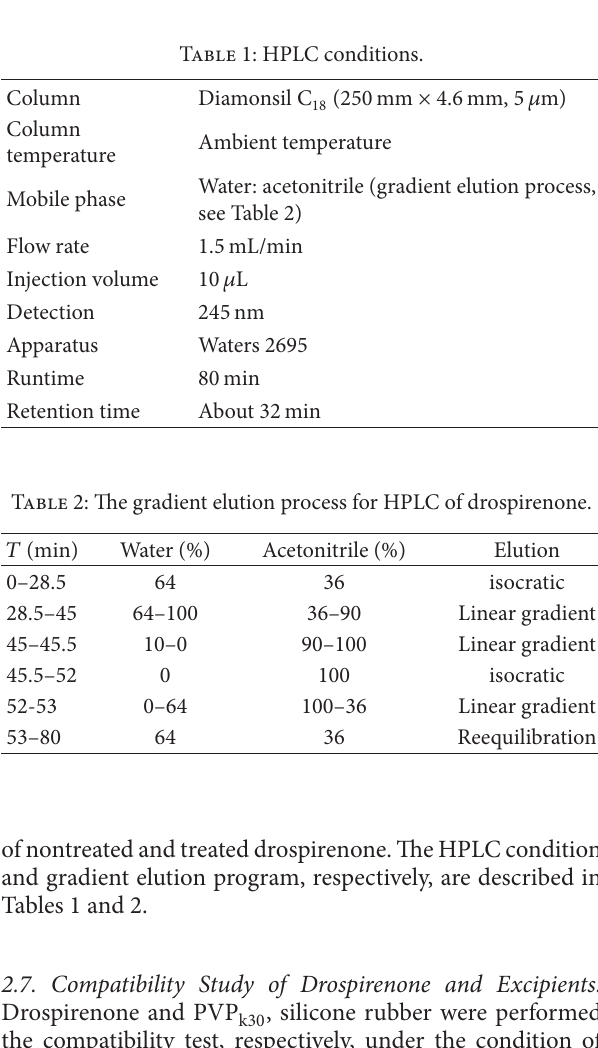
F 3: DSC spectrum of drospirenone under air atmosphere. An endothermic peak corresponding to melting point was obtained for C. No exothermic peak was seen drospirenone crystals at 195.59 in the thermograms suggesting stability of drospirenone-loaded ∘ silicone elastomer matrix in the temperature range